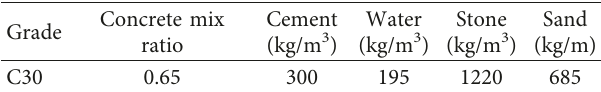
Figure 1: Schematic of the specimens and arrangement of the strain gauges around the columns. Table 2: Concrete mix ratio.